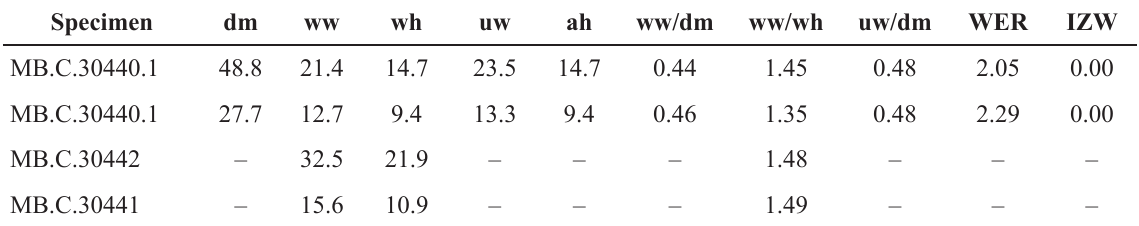
Table 1. Conch dimensions (in mm) and ratios of Rineceras tenerum sp. nov.